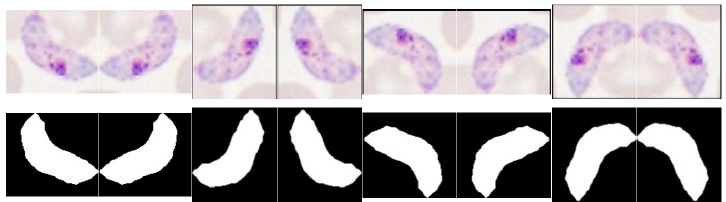
Figure 11. Illustrative examples of the data augmentation